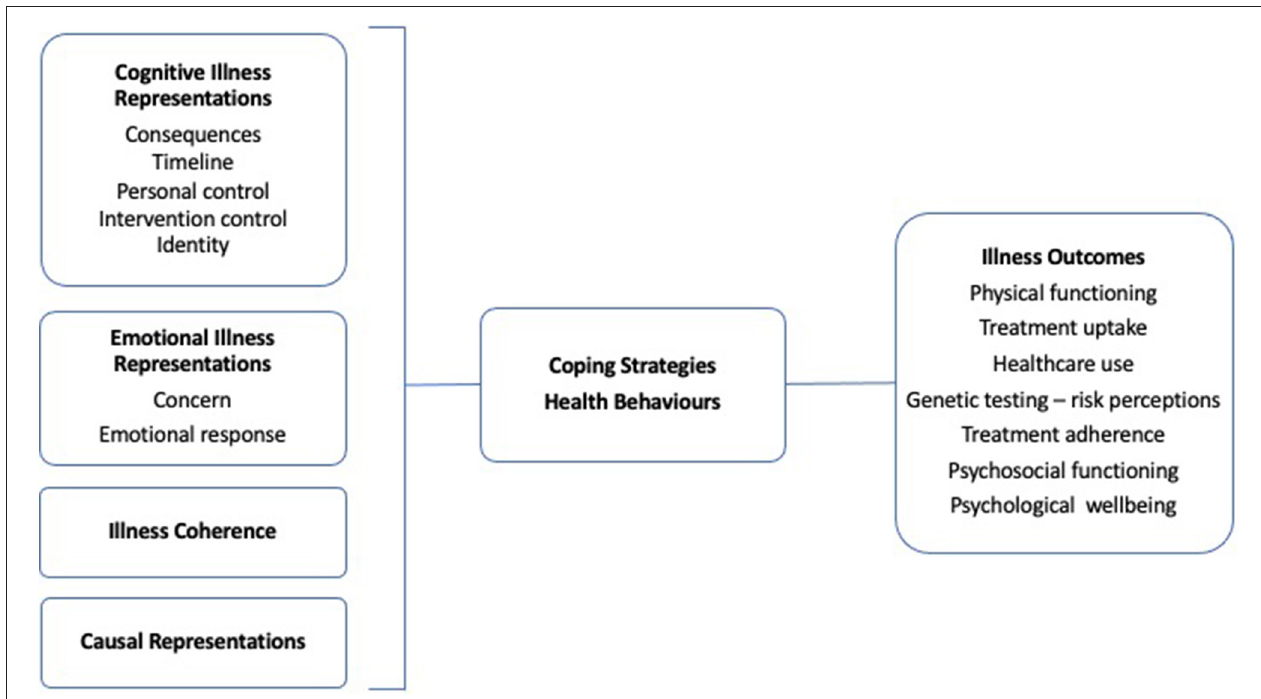
FIGURE 1 | The common-sense model of self-regulation. Basic process model based on Petrie et al., 2007